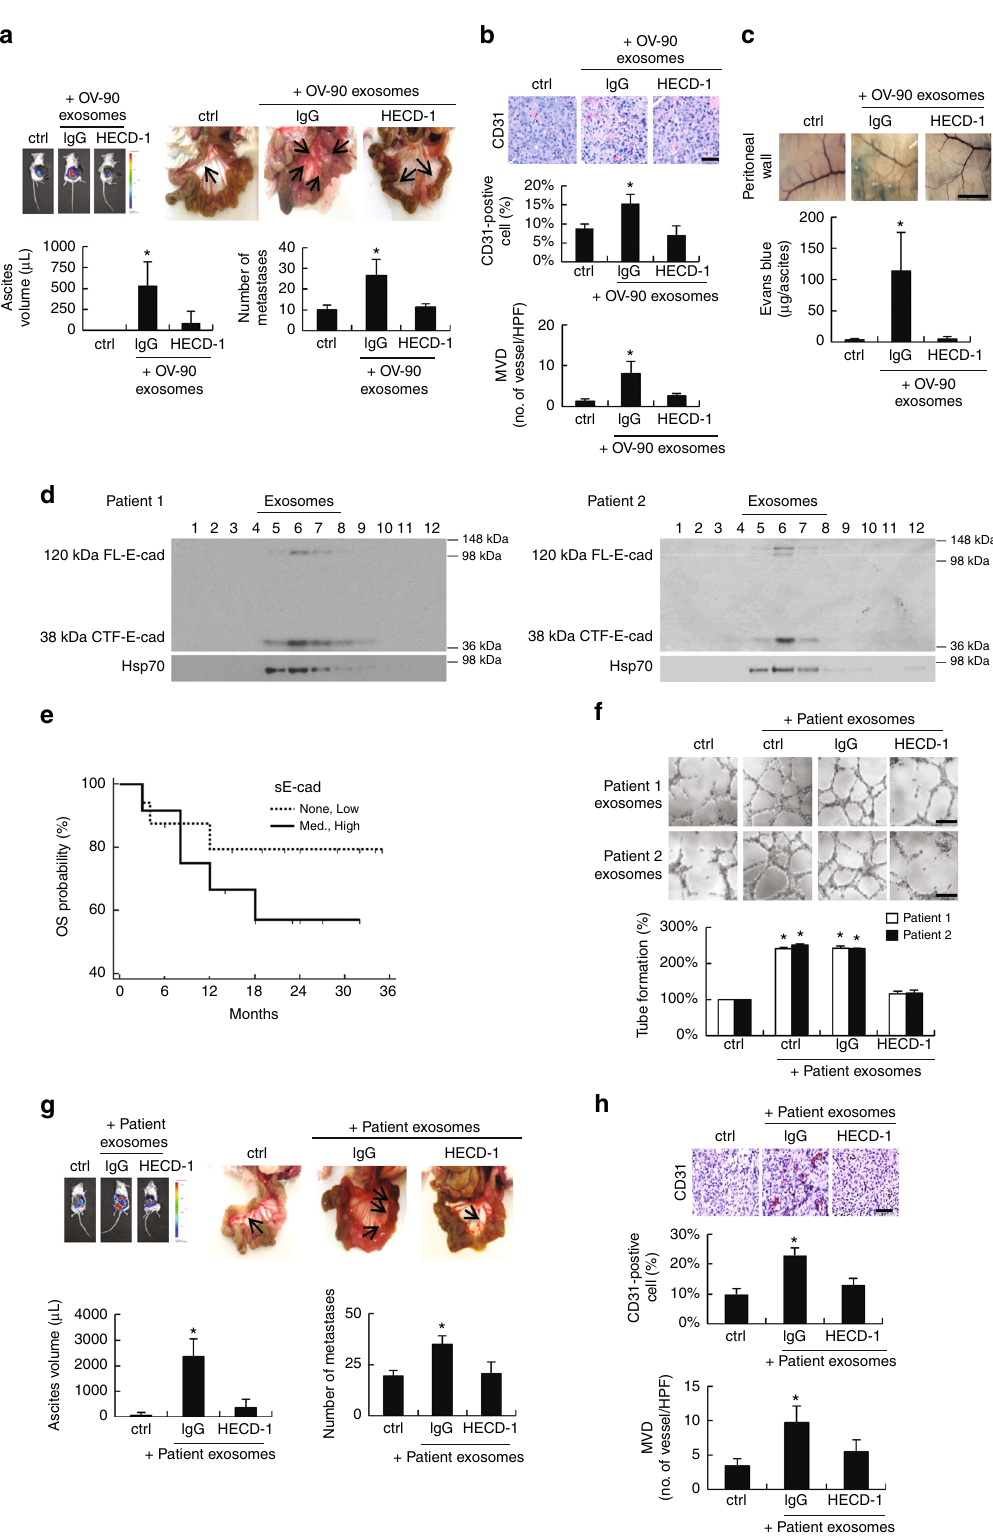
(A5316, 1:5000) (Sigma, St. Louis, MO). The membrane was washed and incubated (610153, 1:1000) (BD Biosciences, San Diego, CA); and anti-CD63 (ab8219, with appropriate secondary antibodies (1:3000) (Bio-Rad) for 1h. Immunor- 1:1000) (Abcam, Cambridge, MA); anti-histone H3 (9715, 1:1000), anti-VE- eactivities were visualized using the enhanced chemiluminescence system (Perkin cadherin (2500, 1:1000), anti-NF κ B p65 (6956, 1:1000), anti-NF κ B p105/p50 Elmer, Waltham, MA). β -actin was probed to ensure equal protein loading. For (12540, 1:1000), anti-NF κ B p100/52 (4882, 1:1000), and anti-RelB (4922, 1:1000) analyzing conditioned medium, equal loading was determined by visualizing total (Cell signaling, Austin, TX); anti-integrin β 1 (MAB1965, 1:1000) (Chemicon, protein level with Coomassie blue staining (Bio-Rad). Scans of the full blots are Billerica, MA); anti-His-tag (70796-3, 1:1000) (Novagen, Darmstadt, Germany); shown in Supplementary Figs. 12 – 18. anti-N-cadherin (C3865, 1:1000), anti-GM130 (G7295, 1:1000), and anti- β -actin NATURE COMMUNICATIONS | (2018) 9:2270 | DOI: 10.1038/s41467-018-04695-7 |